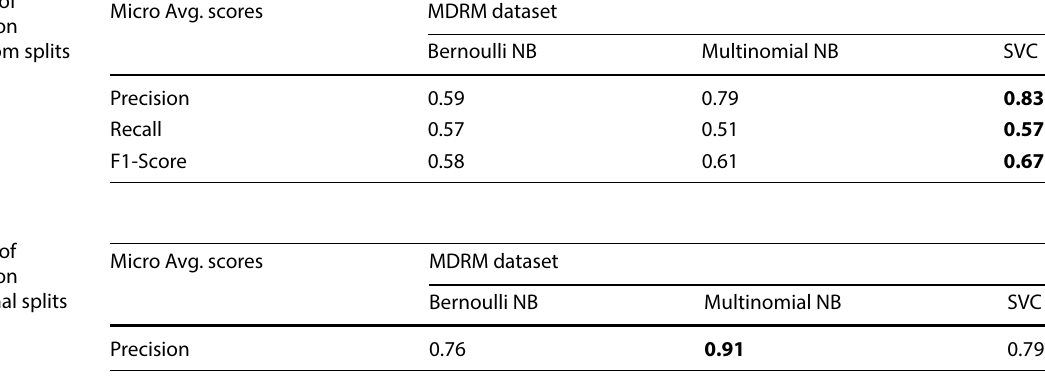
Table 2 Comparison of multiclass classification methods using random splits